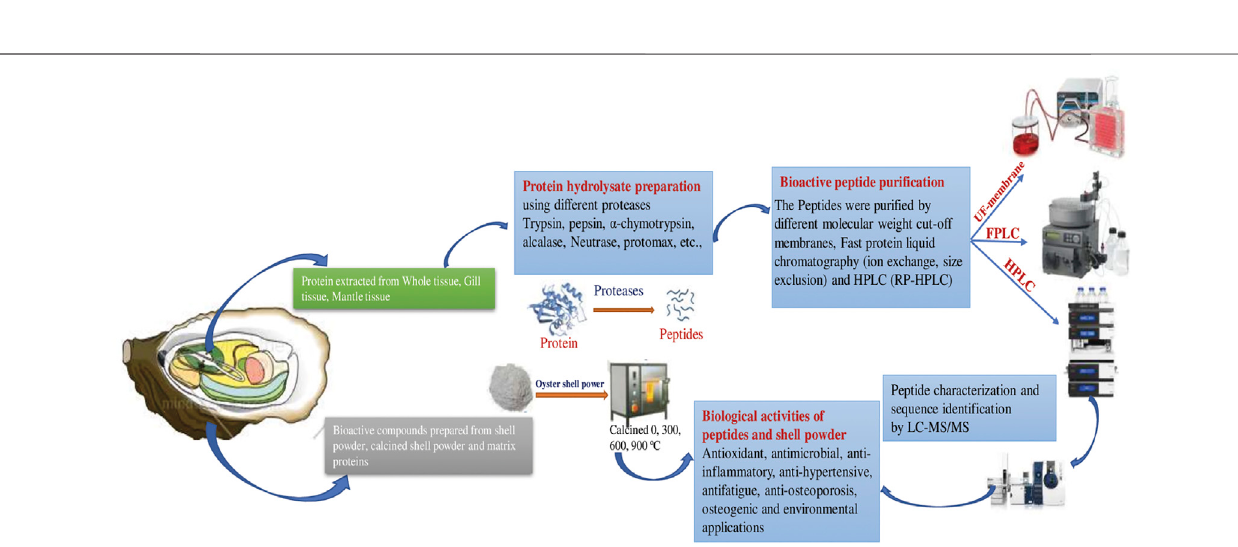
Frontiers in Bioengineering and Biotechnology |